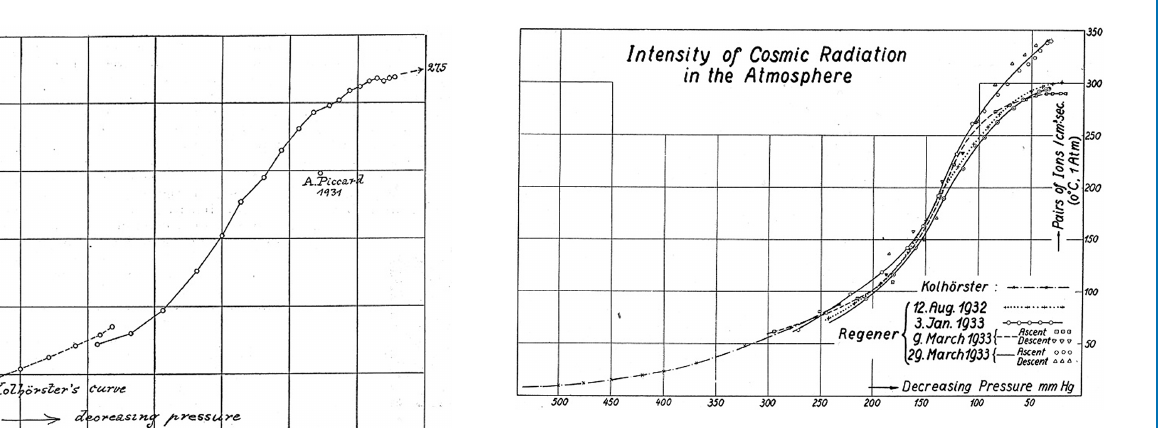
Figure 3. Ionisation data from Regener (1933c). The ionisation rate (ionpairscm − 3 s − 1 ) is shown as function of decreasing pres- sure (mmHg). Results from four flights during 1932–1933 with data corrected to one atmosphere pressure. Also shown are Kolhörster’s